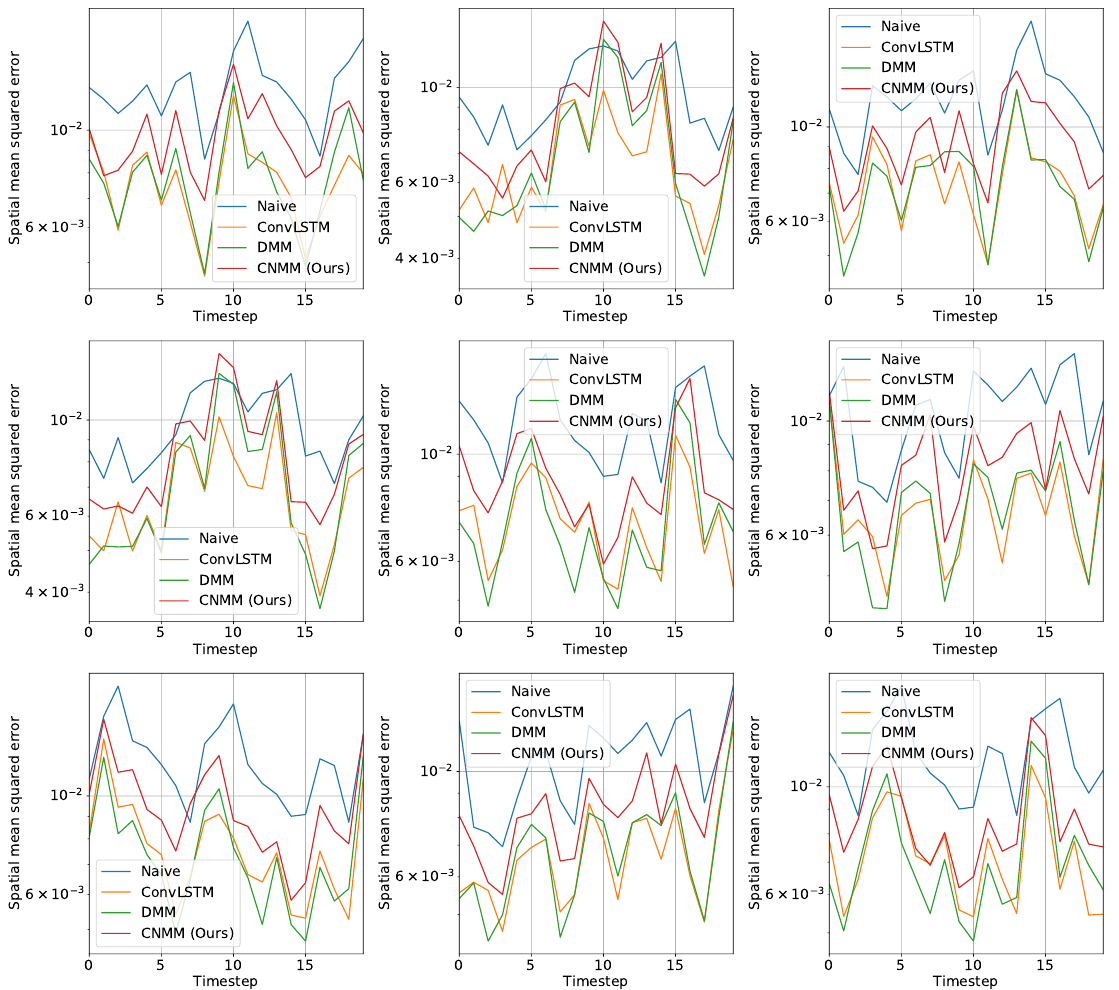
Figure 7. Spatially averaged (spatial mean) squared forecast error of baseline and our models on nine randomly selected CMAP validation data. The length of the forecast is set as 20 timesteps. The y-axis shows the error value, and the x-axis shows the timestep of the forecast. Compared to 2D heat equation data, every DNN model outperformed the naive forecast as expected, due to the higher variance and chaos introduced in the real-world data that are better modeled by DNN models.